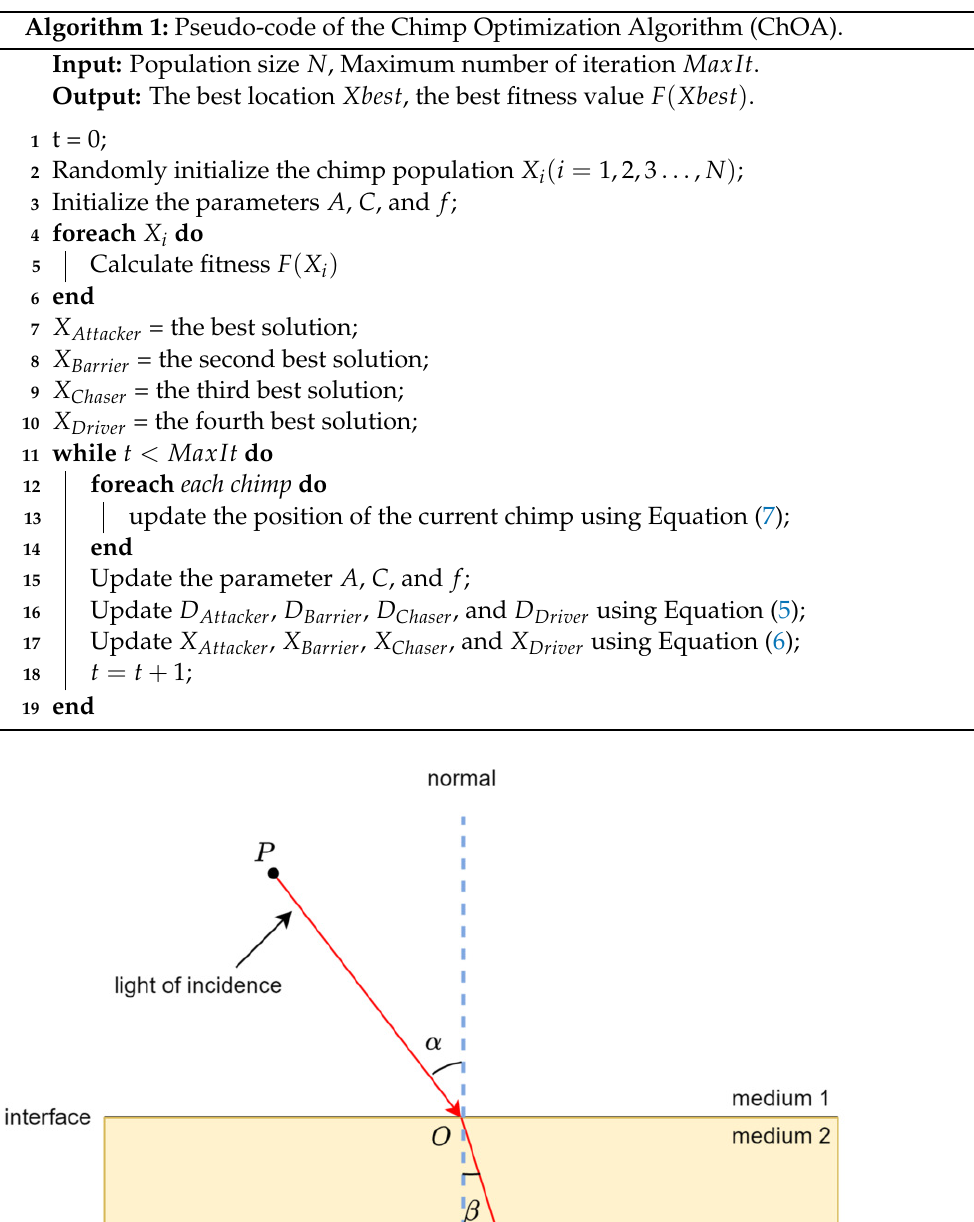
Algorithm 1: Pseudo-code of the Chimp Optimization Algorithm (ChOA).